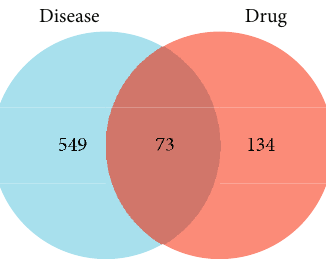
Figure 2: Venn diagram of targets from WMP and